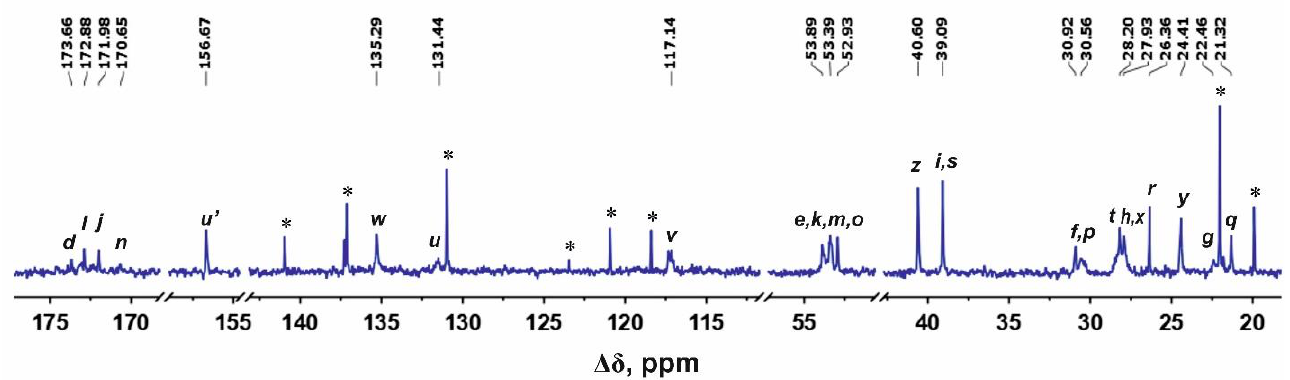
Figure 4. 13 C NMR spectrum of the Lys-His-Arg dendrimer at 298 K. The peaks from small molecular weight impurities are marked by asterix (*).